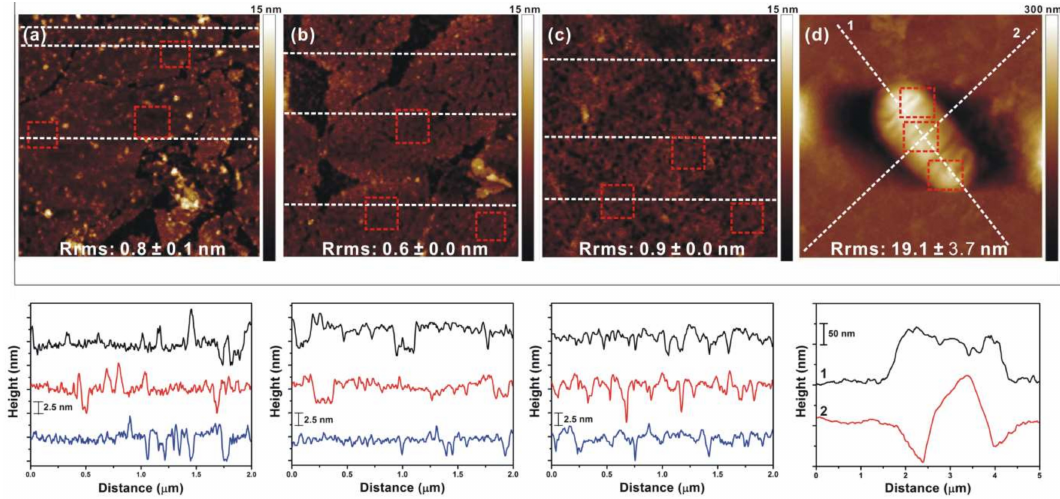
Figure 5. (Upper) AFM topographic images and (lower) sectional profiles of different layer-by-layer fabricated mica. The topmost layer in each image was ( a ) b-PM, ( b ) SpA, ( c ) anti- E. coli antibodies, and ( d ) E. coli K-12 cells. Scan size: ( a – c ) 2 µ m, ( d ) 5 µ m. The b-PM surface prepared via the complex linker and subsequently washed with a microfluidic shear flow was used for the analysis as well as in the following coatings. Bis(NHS)PEG2 was used for SpA conjugation. Red dotted boxes in the images indicate the sectioned areas within each topmost layer for Rrms estimation. Sectional profiles were analyzed along the white dotted lines on the